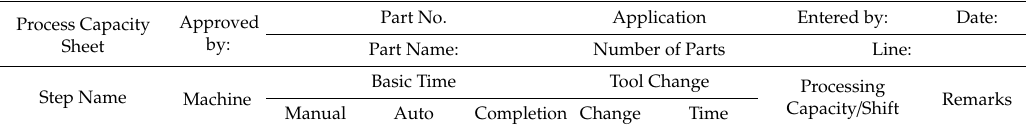
Table 3. Typical process sheet.